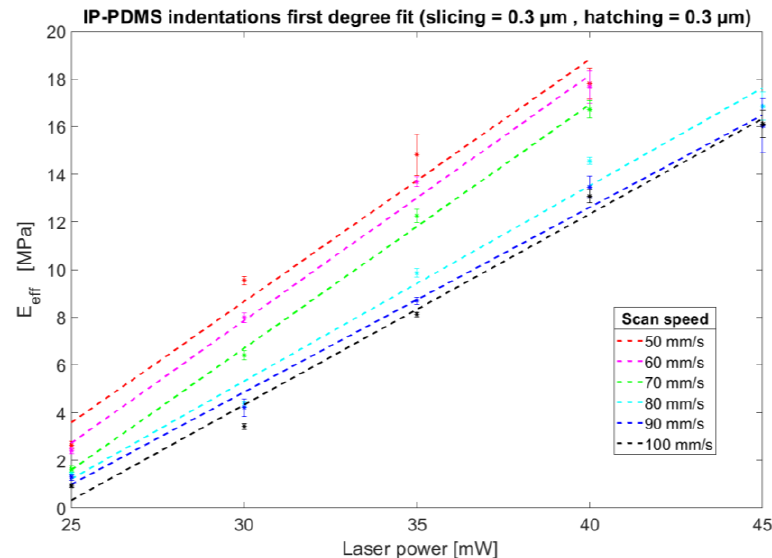
Figure 3. First-degree polynomial fit showing the linear relationship between IP-PDMS’s Young’s modulus and employed laser power at different scan speeds.